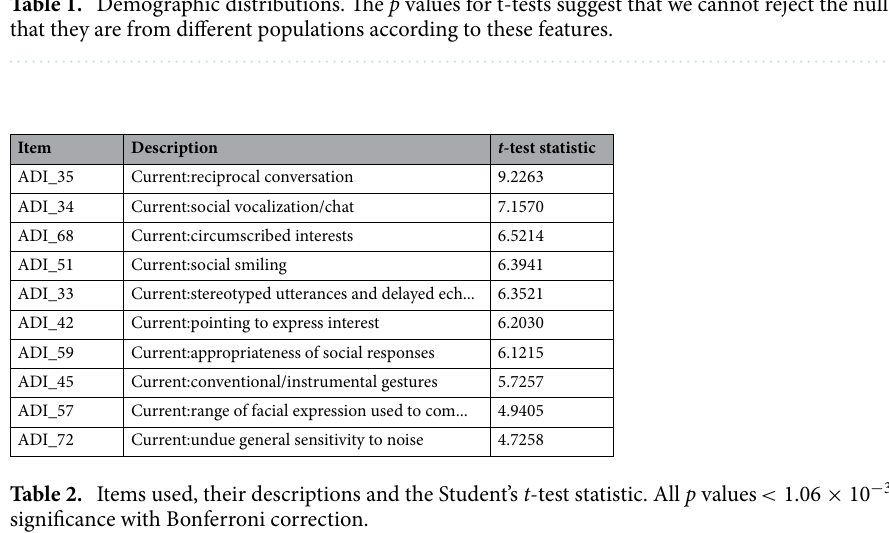
Table 2. Items used, their descriptions and the Student’s t -test statistic. All p values < 1.06 × 10 − significance with Bonferroni